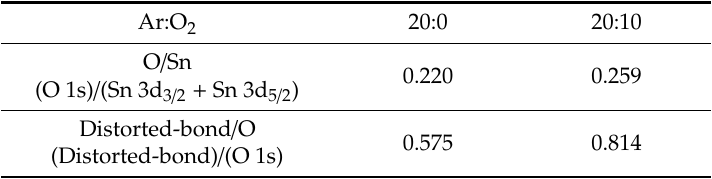
Table 2. Relative elemental composition ratios of the α -GTO thin films.